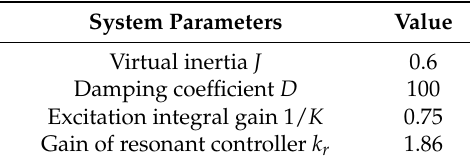
Figure 8. The impact of kr (increased from 0 to 6.3) and the introduced current lowpass filters on the poles distribution of synchronverter system. Cross: poles without current lowpass filters. Asterisk: poles with current lowpass filters. Table 2. Parameters of VSG system.